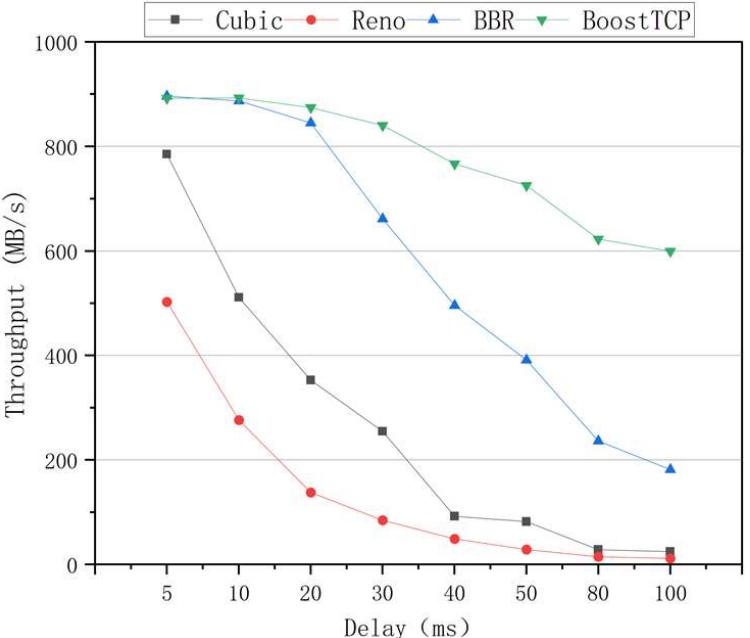
Figure 9. The throughput curves of the four congestion control algorithms versus the network delay at a packet loss rate of 0.05%.